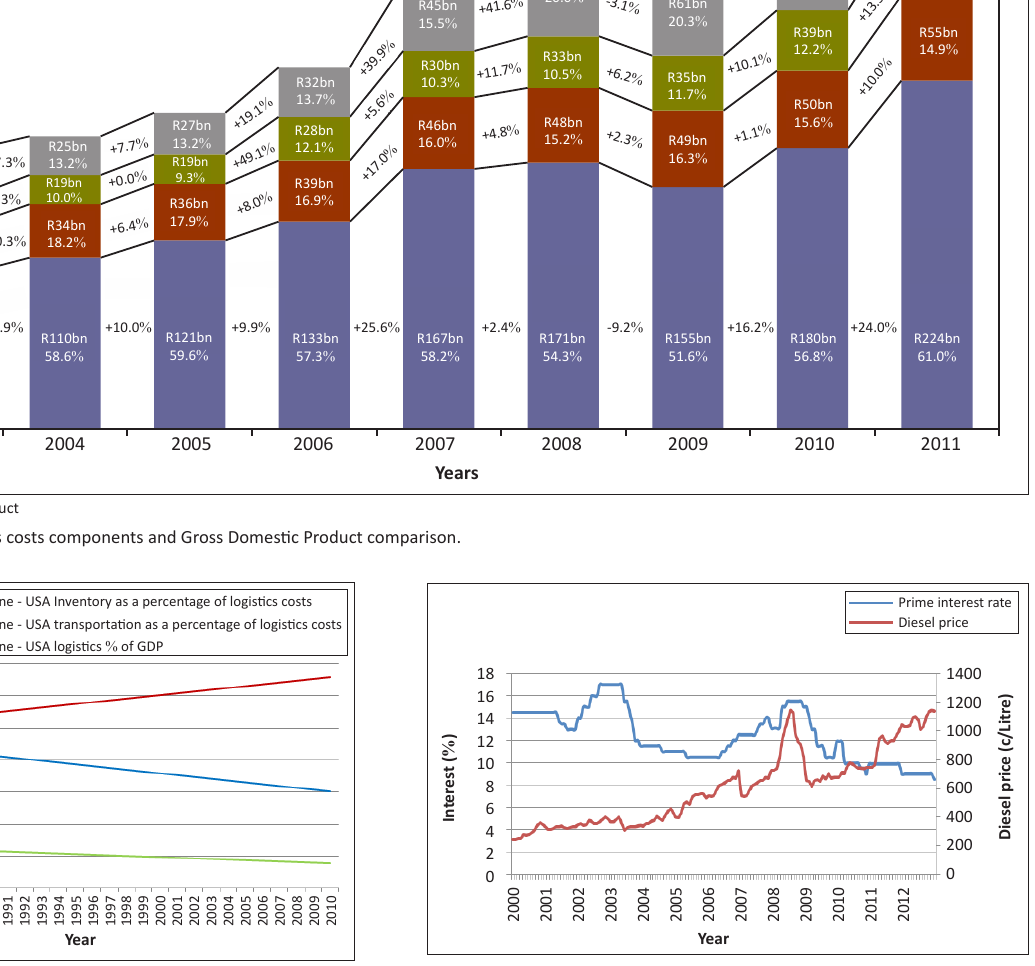
FIGURE 3: Trends in South Africa’s fuel price and prime interest rate.